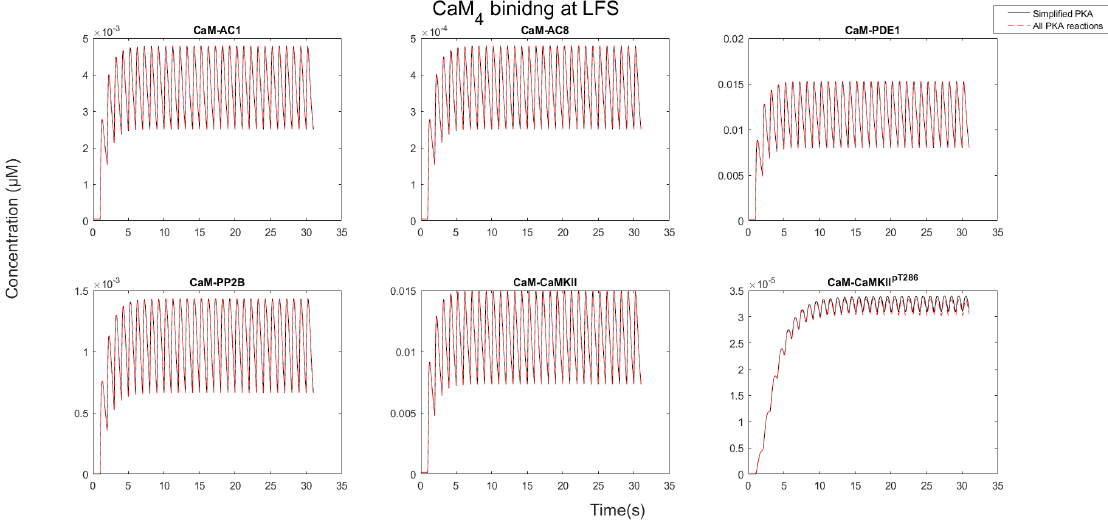
Figure 9. CaM 4 bound fractions during LFS for 30 pulses. Note how PDE1 and CaMKII bound to the most but were unstable. In addition, note how CaMKII was not able to achieve stable phosphorylation. Overall, every protein is subject to much dissociation between each decaying pulse.